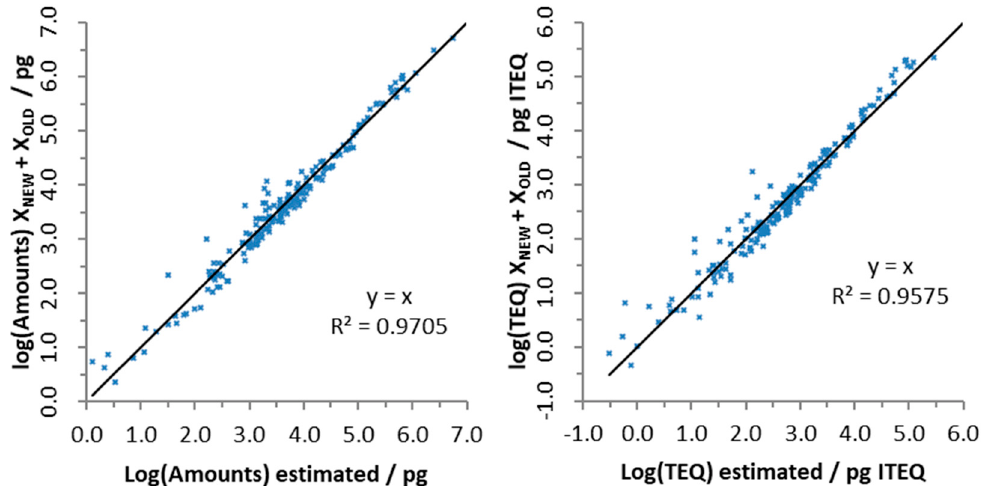
Figure 2. Total amount determined by model 1’ ( left ) and total toxicity determined by model 2’ ( right ), both calculated considering congeners 1, 10 and 14 as linearly independent.